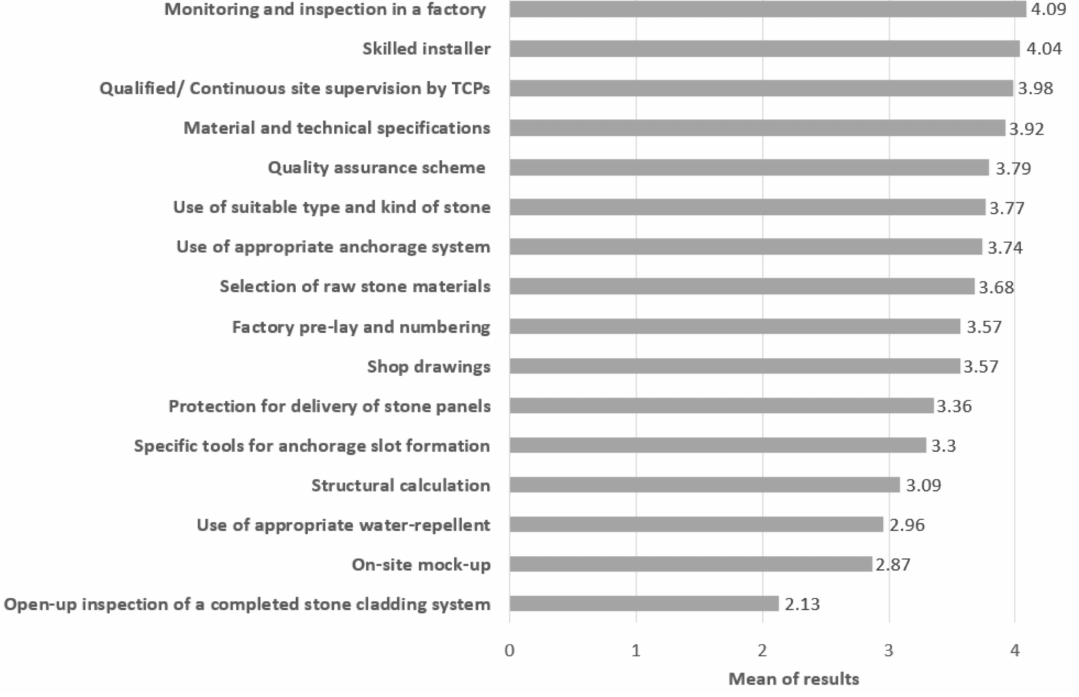
Figure 8. Factors that are crucial to the successful installation of the external stone cladding system and minimize its defects in HK ( n =